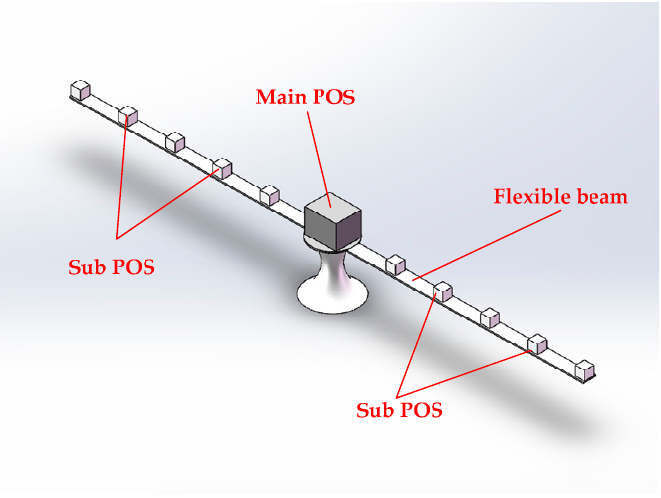
Figure 4. Schematic diagram of distributed position and orientation system (POS) technology scheme.